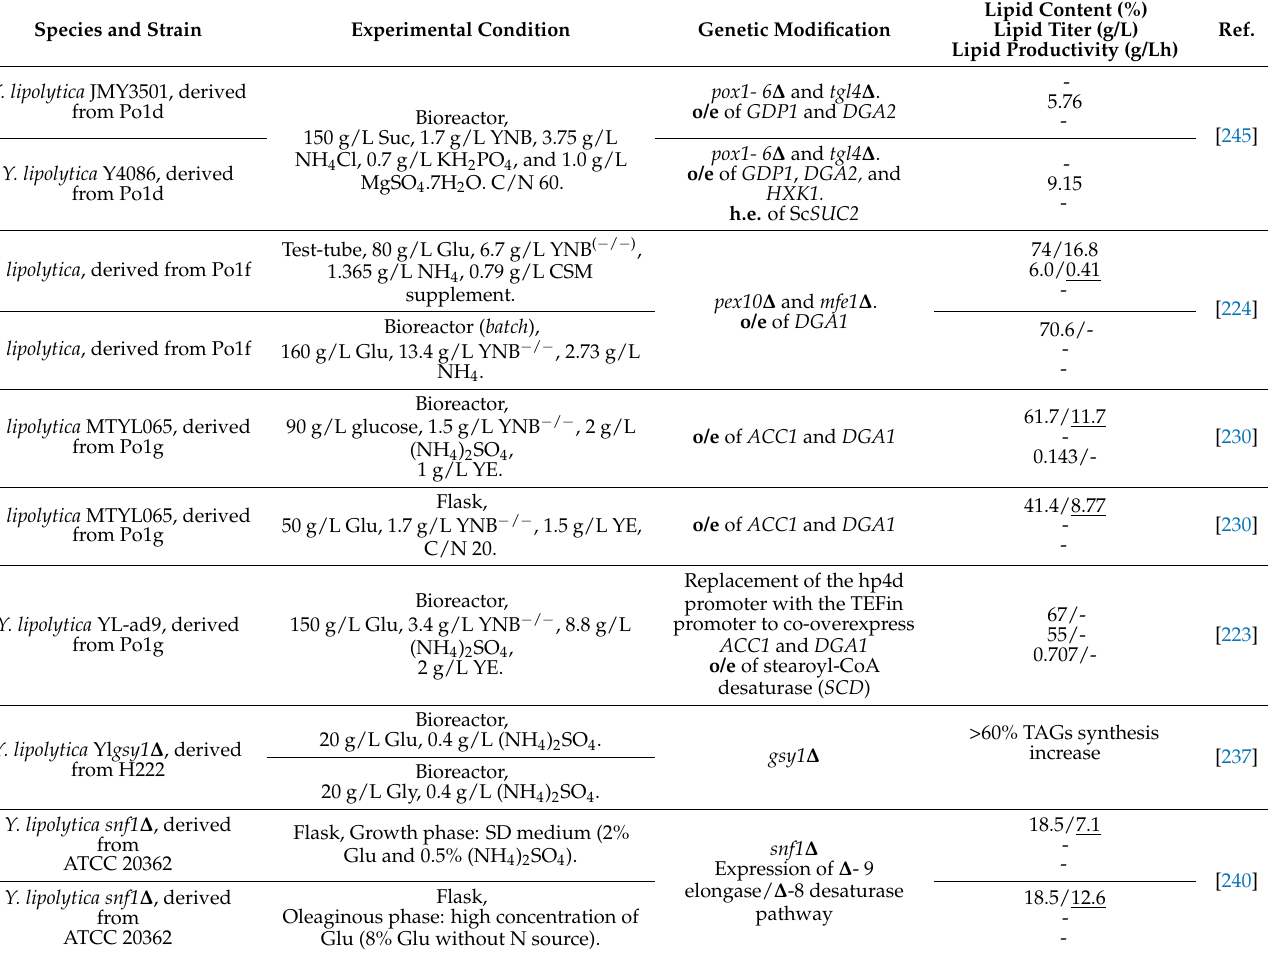
Table 6. Genetic modifications performed in different oleaginous yeasts to increase lipid produc- tion. A brief description of the experimental conditions and genetic modification, as well as lipid production, is also presented. The species covered in the table are Yarrowia lipolytica , Rhodotorula toruloides , Rhodotorula fluvialis and Candida phangngensis . The underlined values correspond to the lipid production parameters obtained for the parental